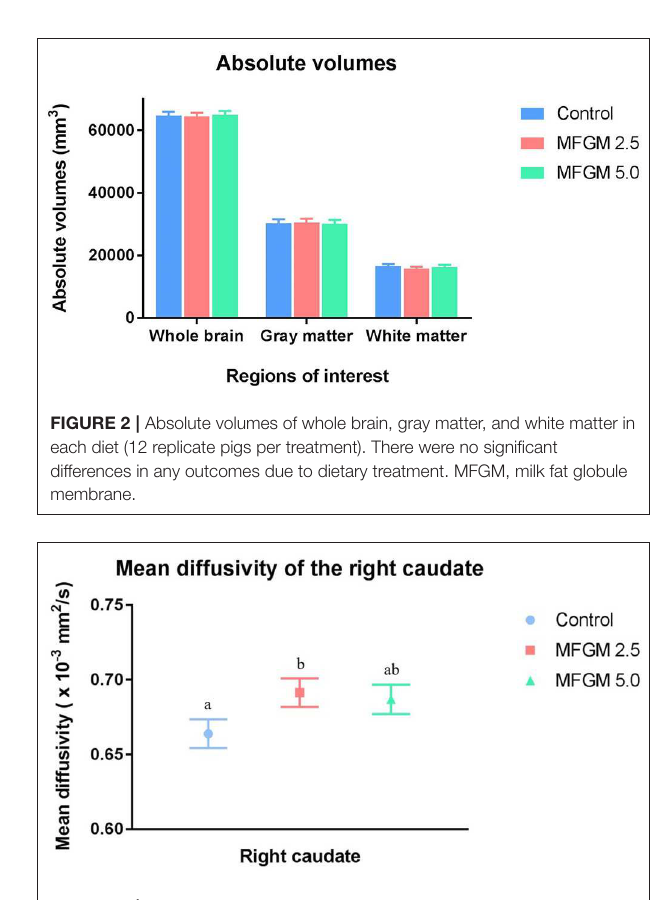
FIGURE 3 | Mean diffusivity values for the right caudate (12 replicate pigs per treatment). Pigs fed MFGM-2.5 exhibited higher ( P < 0.05) mean diffusivity values compared with CONT pigs. Mean diffusivity in MFGM-5.0-fed pigs did not differ from the other treatments. Means without a common superscript letter differ ( P < 0.05). MFGM, milk fat globule